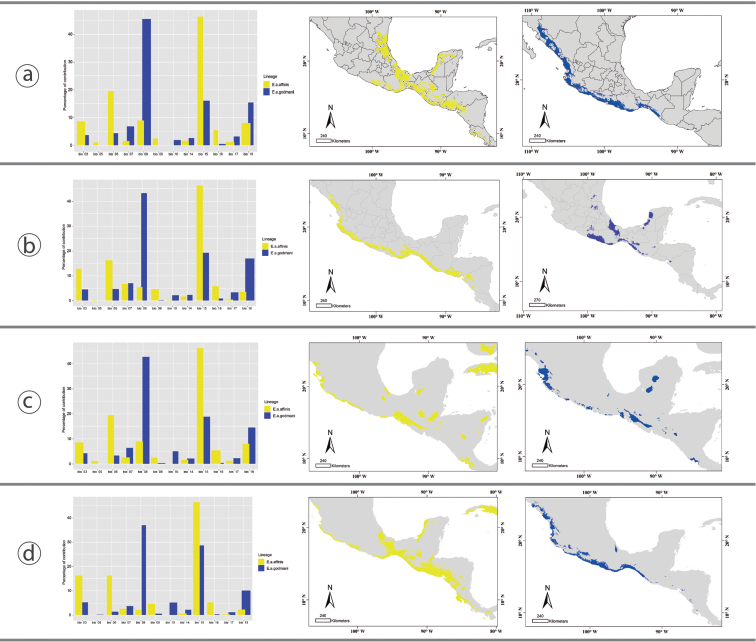
Ecological niche modelling and its projection in the geographic areas for E.
a.
affinis (yellow) and E.
a.
godmani (blue). In all four panels (a-d), the contribution values of each environmental variable of ENM’s is illustrated in the left and the projection of the Ecological niche conditions in the geographic distribution area is shown in the maps. a Ecological Niche projected in the current geographic distribution area of E.
affinis and E.
a.
godmani. b ENM’s projected into the geography for each lineage. c ENM of E.
a.
affinis and E.
a.
godmani projected in the Last Maximum Glacial ecological conditions. d ENM of E.
a.
affinis and E. a. godmani projected in the Last Inter Glacial ecological conditions.